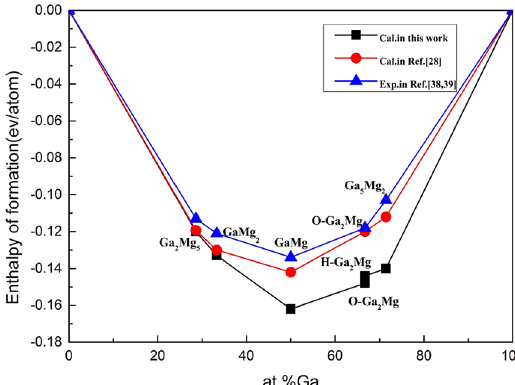
Figure 3. Calculated enthalpies of formation plotted as a function of composition for the Ga-Mg system.